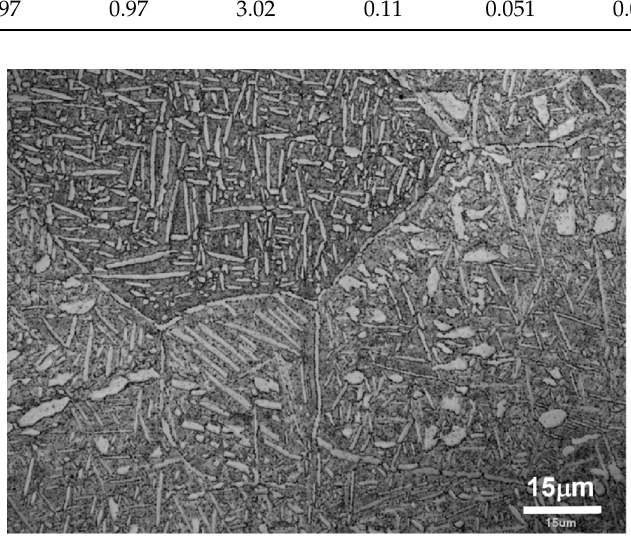
Figure 1. The initial microstructure of Ti–10V–1Fe–3Al